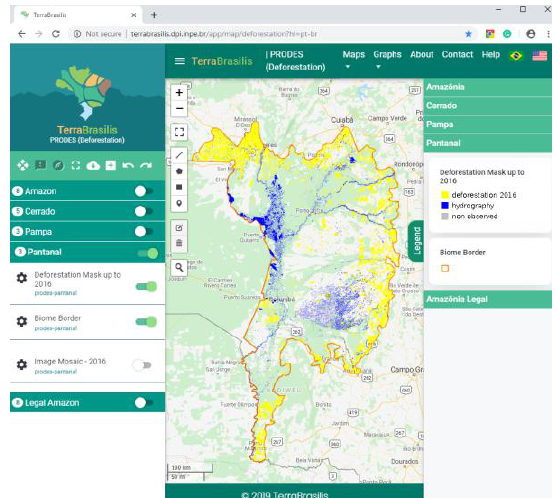
Figure 11. TerraBrasilis web platform developed by INPE for dissemination of deforestation monitoring data. Available at